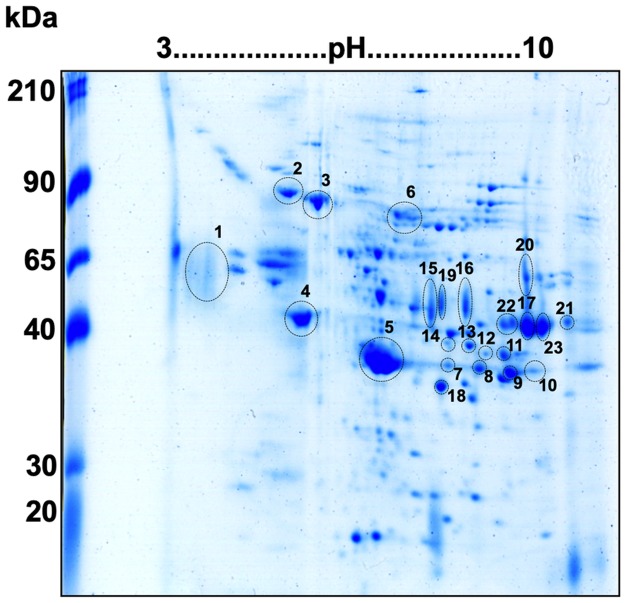
Coomassie blue-stained 2D-PAGE showing spots matched to the 2D-WB.Proteins from SEE were resolved in 7 cm, pH 3–10 strip and stained by Coomassie G-250. Immunoreactive spots from infected S. mansoni sera were numbered (n = 23) and were excised and submitted for mass spectrometry identification.